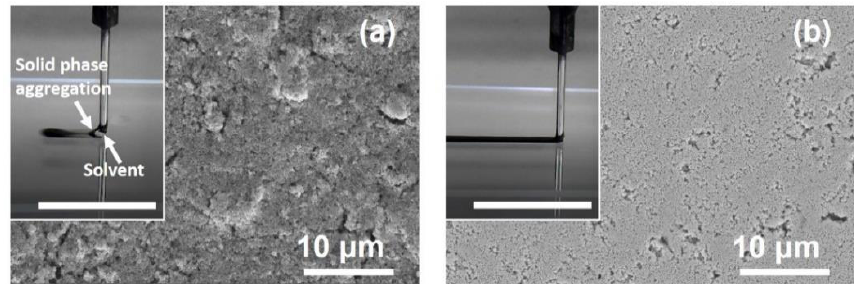
Figure 5. Microstructures of the interconnects printed using inks pretreated by ( a ) ultrasound and ( b ) the mechanical-ultrasonic combined method, respectively. The insets show the corresponding printing processes. The scale bars in the insets stand for 20 mm.